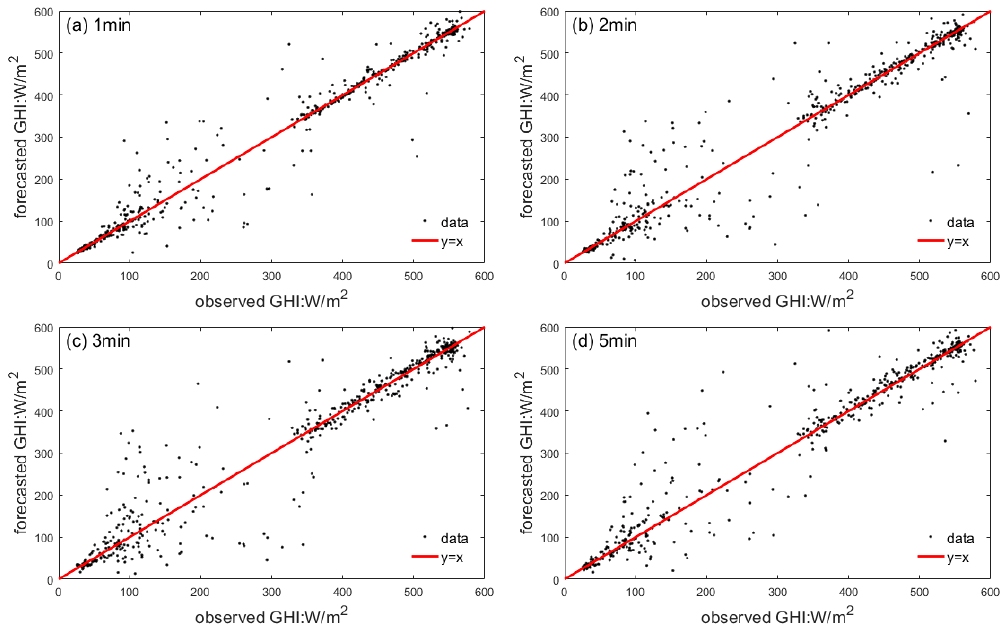
Figure 13. Scatter plots of GHI forecasting based on the BPN model for 1 min ( a ), 2 min ( b ), 3 min ( c ), 5 min ( d ) on 11 November 2017 .